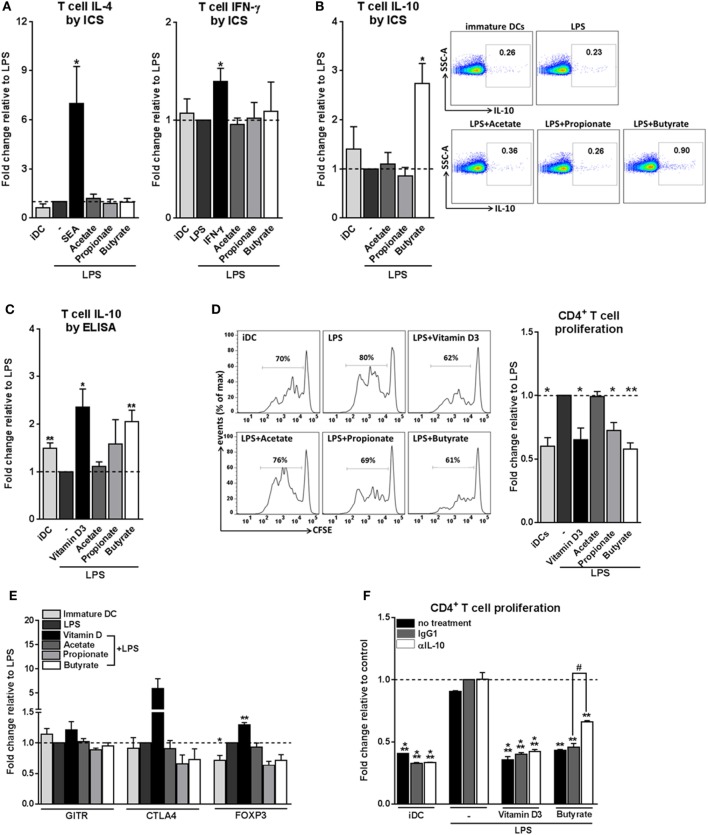
Butyrate conditions human dendritic cells (DCs) to induce type 1 regulatory T cells. (A–C) Differently stimulated DCs were cocultured with allogenic naive CD4+ T cells. After 11 days, cytokine production by T cells was analyzed (A,B) by intracellular cytokine staining by flow cytometry after 6 h of stimulation with PMA and ionomycin or (C) by ELISA after 24 h restimulation with anti-CD3/CD28. (A–C) Data represent fold change in panels (A,B) percentage of T cells that stain positive for indicated cytokines or in panel (C) IL-10 levels in culture supernatants, relative to data from LPS-stimulated DCs which was set to 1 for each cytokine (dashed line). (B) Representative flow cytometry plots are shown on the right. (D) T-cell suppression assay in which irradiated test T cells were cocultured with activated CFSE-labeled responder CD4+ T cells. On day 6, CFSE dilution of the responder T cells was assessed by flow cytometry. The left panels are representative histograms of CFSE dilution by responder T cells. Quantification of these data is shown in the bar graph and is depicted as fold change relative to data from LPS-stimulated DCs, which was set to 1 (dashed line). (E) Expression of regulatory markers by T cells was analyzed by flow cytometry. Bar graphs represent relative differences based on geometric mean fluorescence for glucocorticoid induced TNF receptor (GITR) and cytotoxic T-lymphocyte-associated protein 4 (CTLA4) or frequency of T cells that express forkhead box P3 (FOXP3). (F) For the duration of the assay as described in panel (D) indicated antibodies were added. Data are from one experiment representative of two, shown as means ± SEM of triplicates. (A–E) Bar graphs represent means ± SEM of at least three experiments. *,#p < 0.05, **p < 0.01, ***p < 0.001 for significant differences with the control (*) or between test conditions (#) based on paired Student’s t-test.